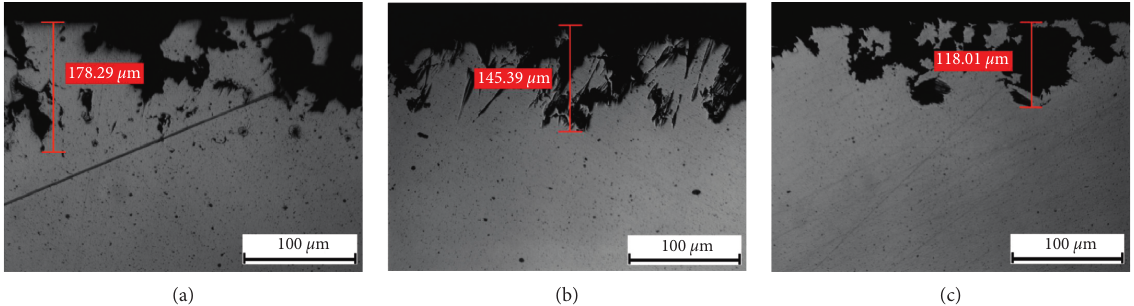
3 solution for 72 (h): (a) 1.19 wt.% (N), (b) 1.28 wt.% (N),